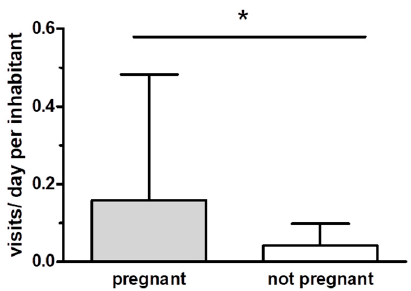
Figure 2. Healthcare utilization of pregnant women of the three cohorts versus the mean of the age- and gender-matched subgroup within the respective refugee cohort (bars display mean plus SD from both cohorts, * p < 0.05).